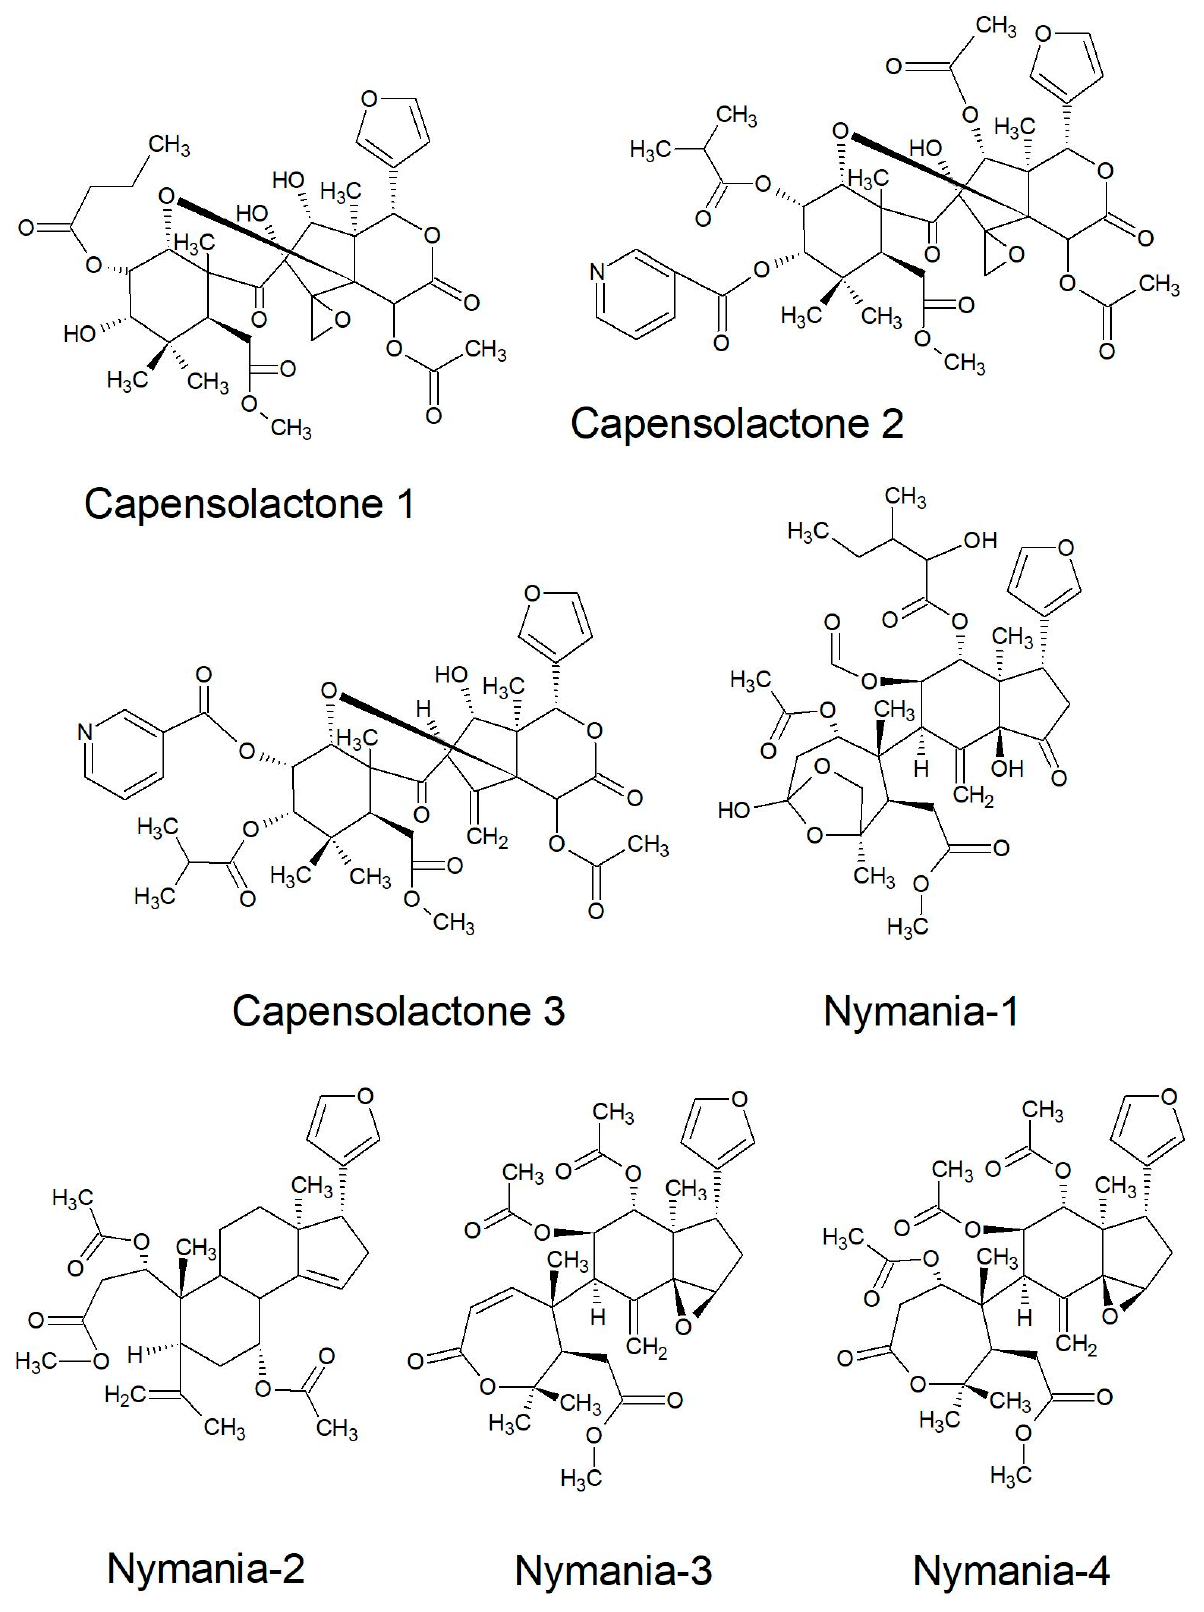
Figure 7. Capensolactones and Nymania series of limonoids reported from South African Meliaceae [108,112].